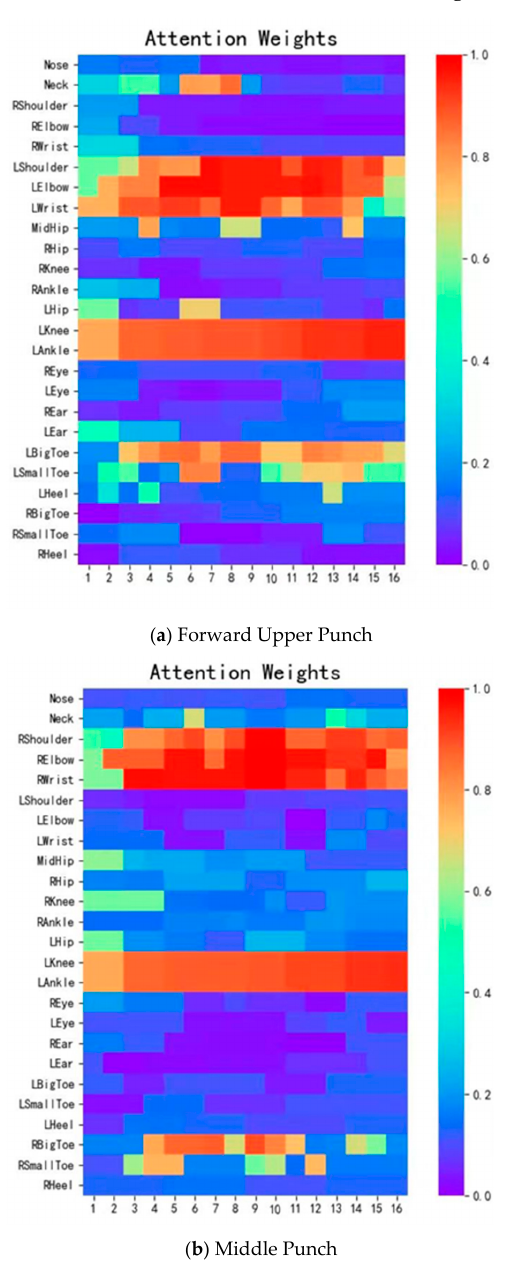
Figure 9. Karate technique attention mechanism heat map. The x -axis is the frame of the video, and the y -axis is the action category.